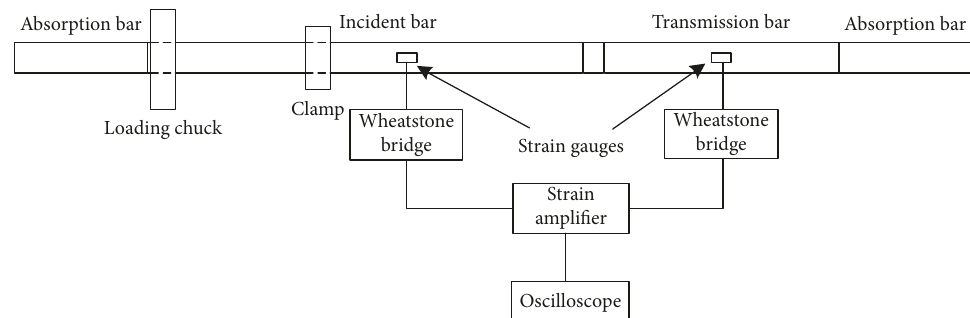
Figure 16: Schematic diagram of the single pulse loading TSHB